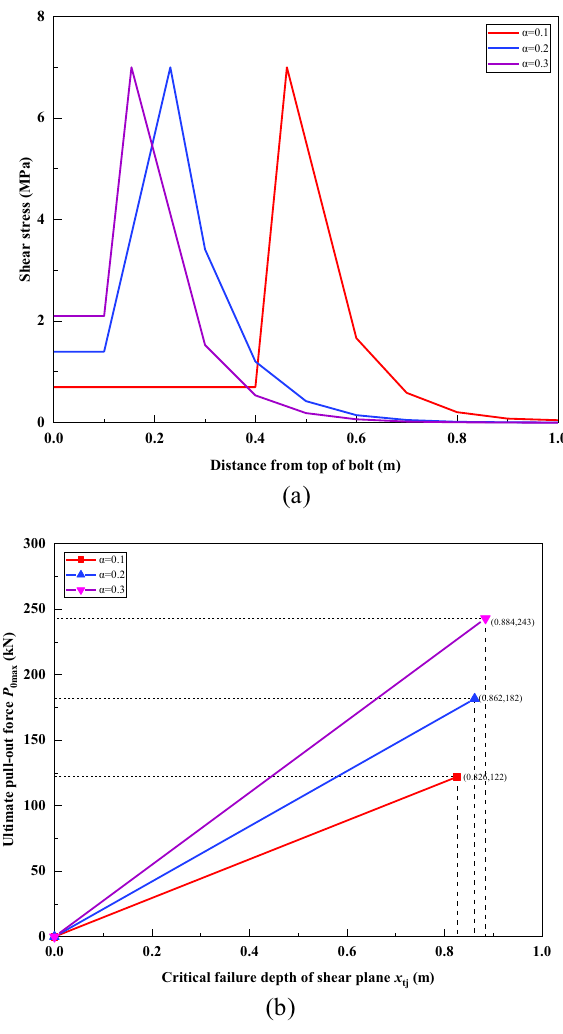
Figure 23. Effect of parameter α . ( a ) Under 100 kN load, the influence of different α on the distribution of shear stress; ( b ) The influence of different α on the ultimate pull-out force of the